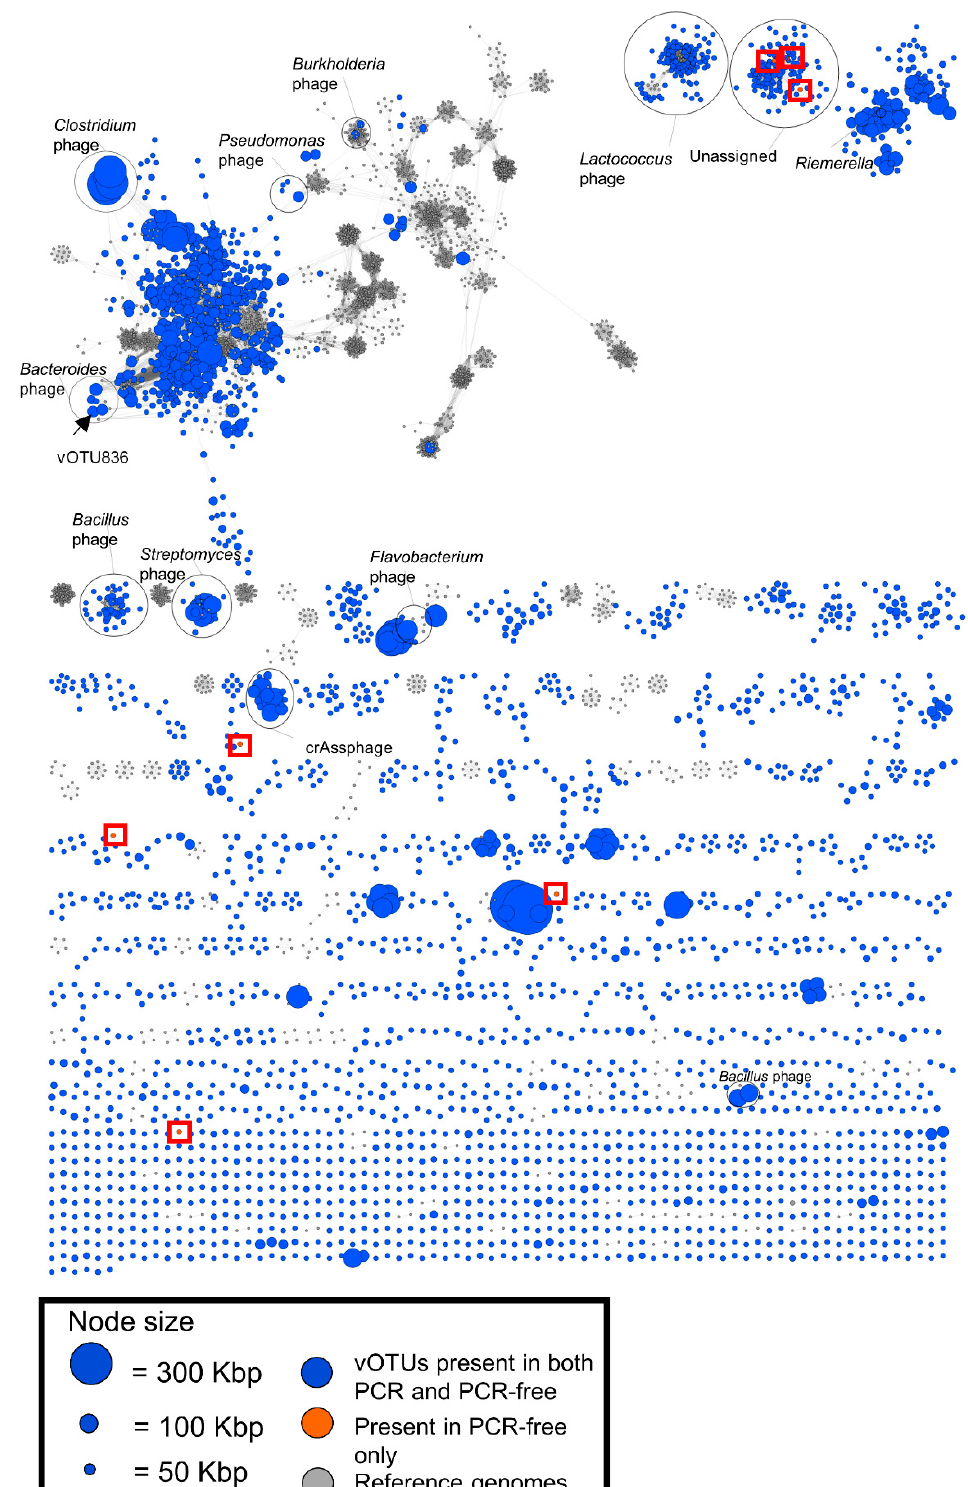
Figure 7. Viral cluster network displaying the non-redundant viral sequence similarity for both the PCR and PCR-free datasets. vOTUs are grouped into a viral cluster with shared sequence similarity based on amino acid homology against reference genomes (grey circles). The nodes (blue circles) represent vOTUs and edges (grey lines) represent the weighted similarity between the vOTUs. The red boxed orange nodes, were only present in PCR-free datasets.